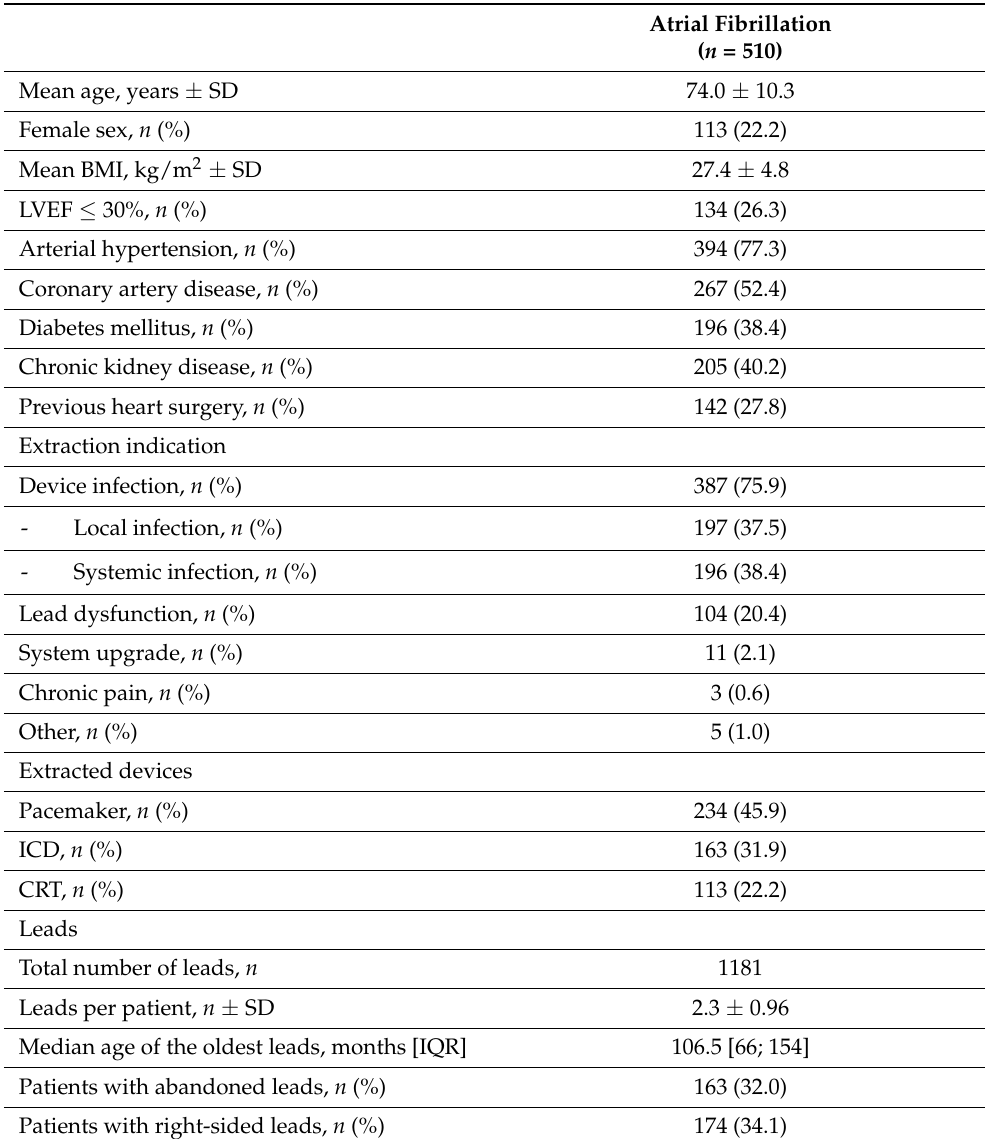
Table 1. Patient and lead